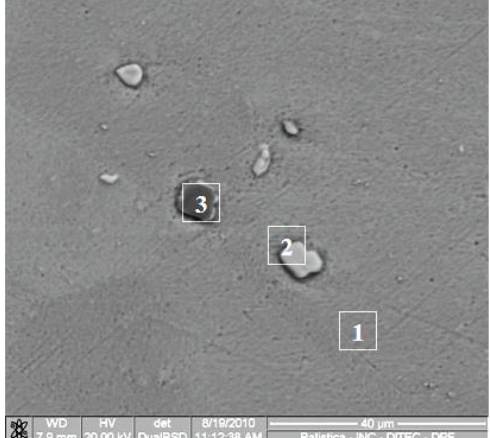
Figure 3. Scanning Electron Microscopy (SEM) micrograph of heat treated superalloy VAT 36 in backscattered electron image. Magnification: 3000×. Matrix (1) and two different precipitates (2 and 3).